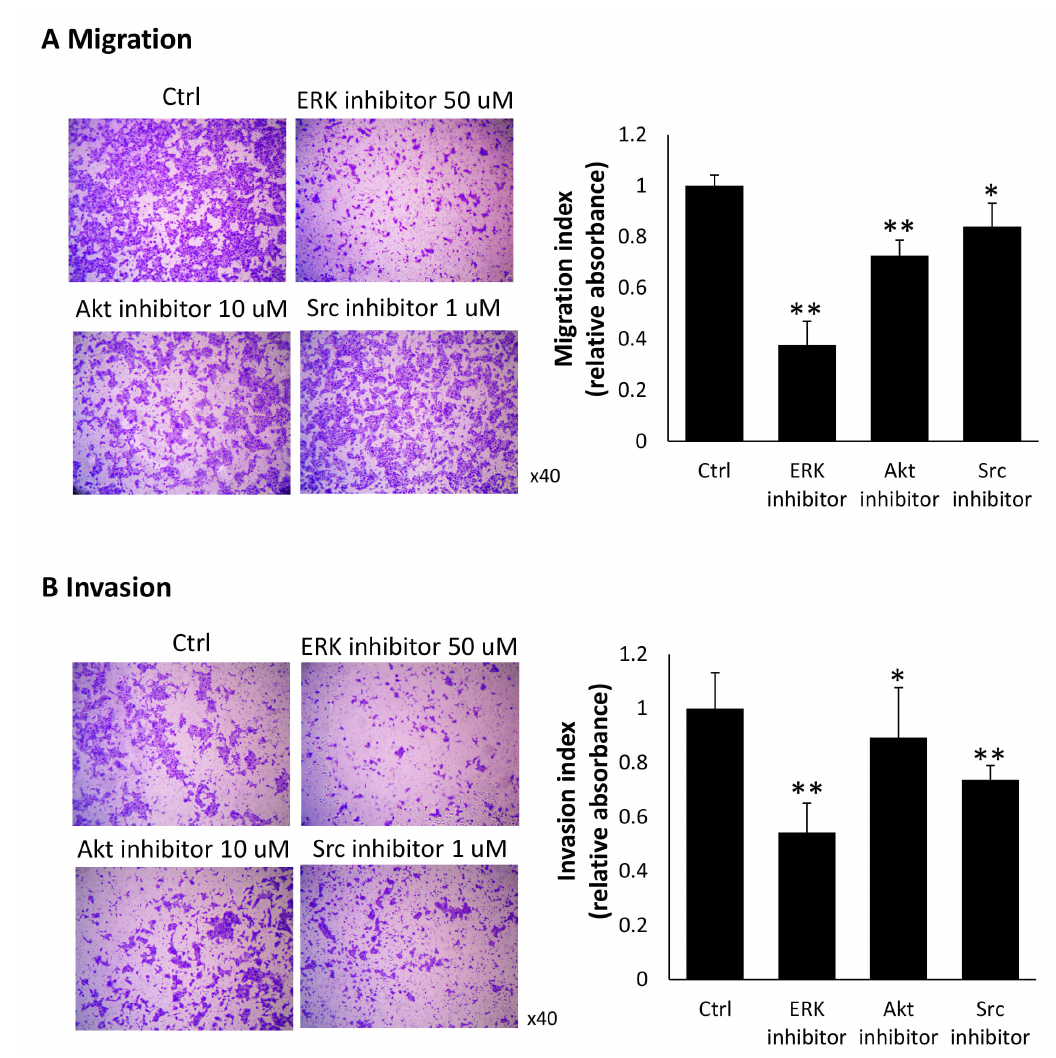
Fig. 4. Inhibitors of ERK, Akt and Src suppressed migration and invasion ability of DU145 cell line. DU145 cells were treated with ERK inhibitor (PD98059, 50 µ M), Akt (LY-294002, 10 µ M) and Src inhibitor (Bosutinib, 1 µ M) for 24 hours. (A) Migration assay. (B) Invasion assay. All data are expressed as the mean ± standard deviation from three independent experiments. * p < 0.05; ** p < 0.01 versus Ctrl. Magnification: ×